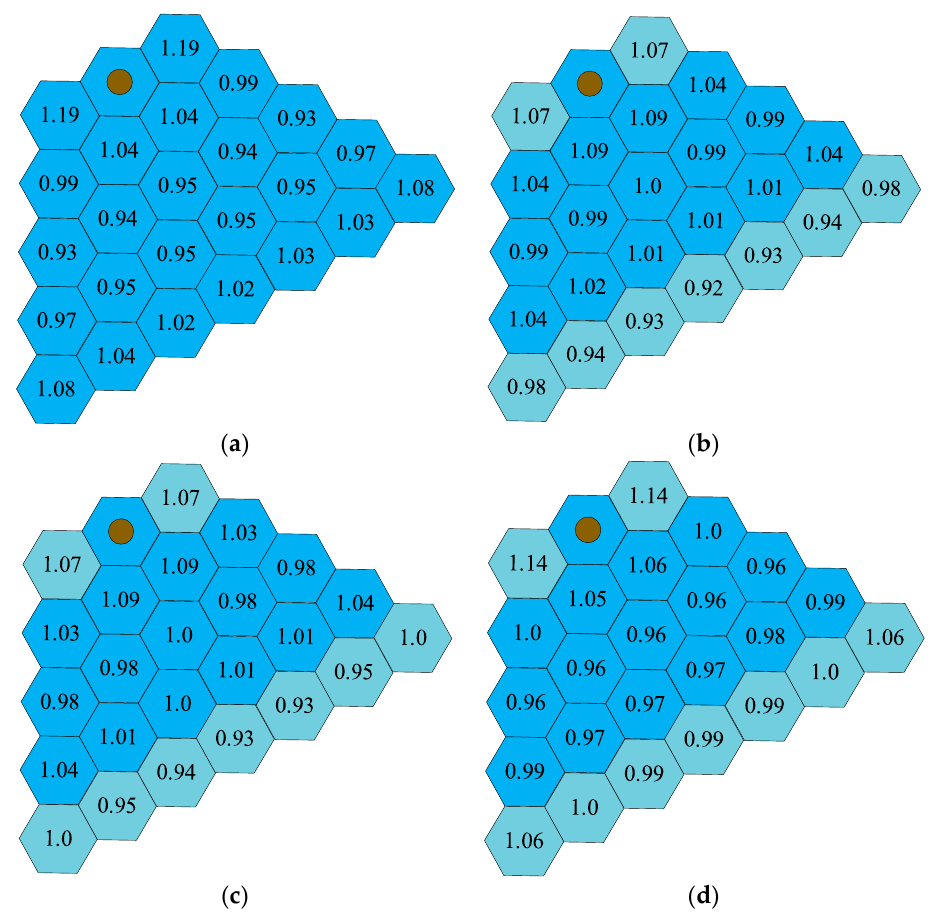
Figure 13. Initial power distributions in fuel assembly (one-sixth assembly). ( a ) 18.6% fuel enrich- ment; ( b ) 15.7% + 19.8% fuel enrichment; ( c ) 15.84% + 19.75% fuel enrichment; ( d ) 17.4% + 19.1% fuel enrichment.